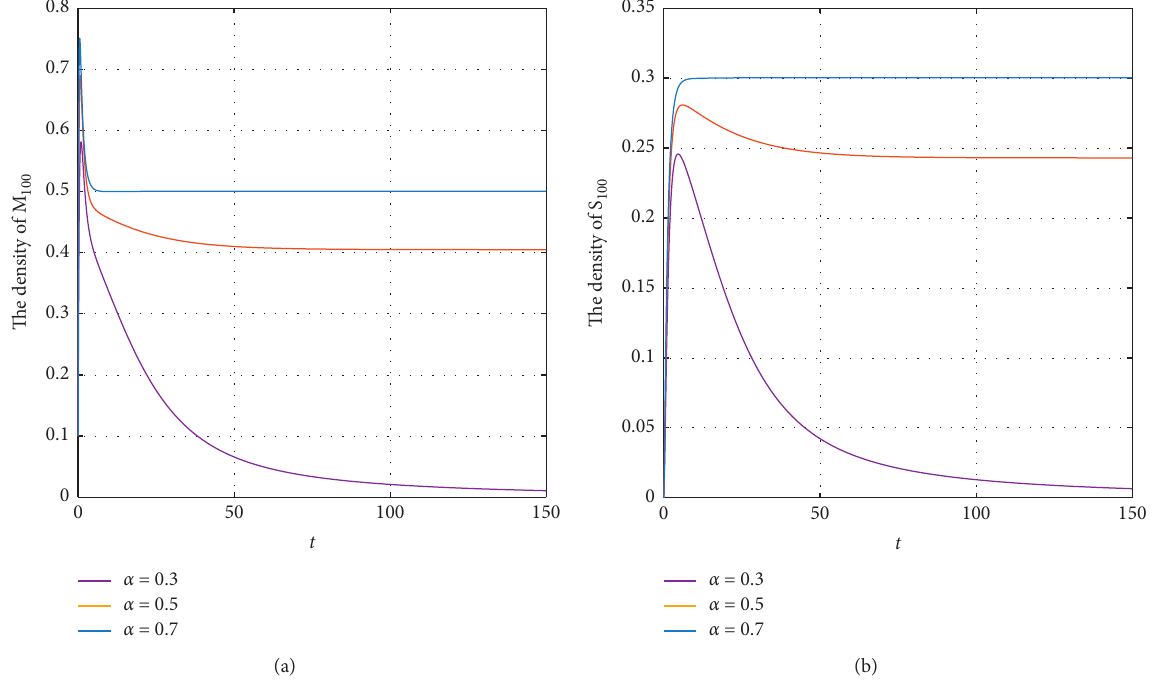
Figure 6: The prevalence of M